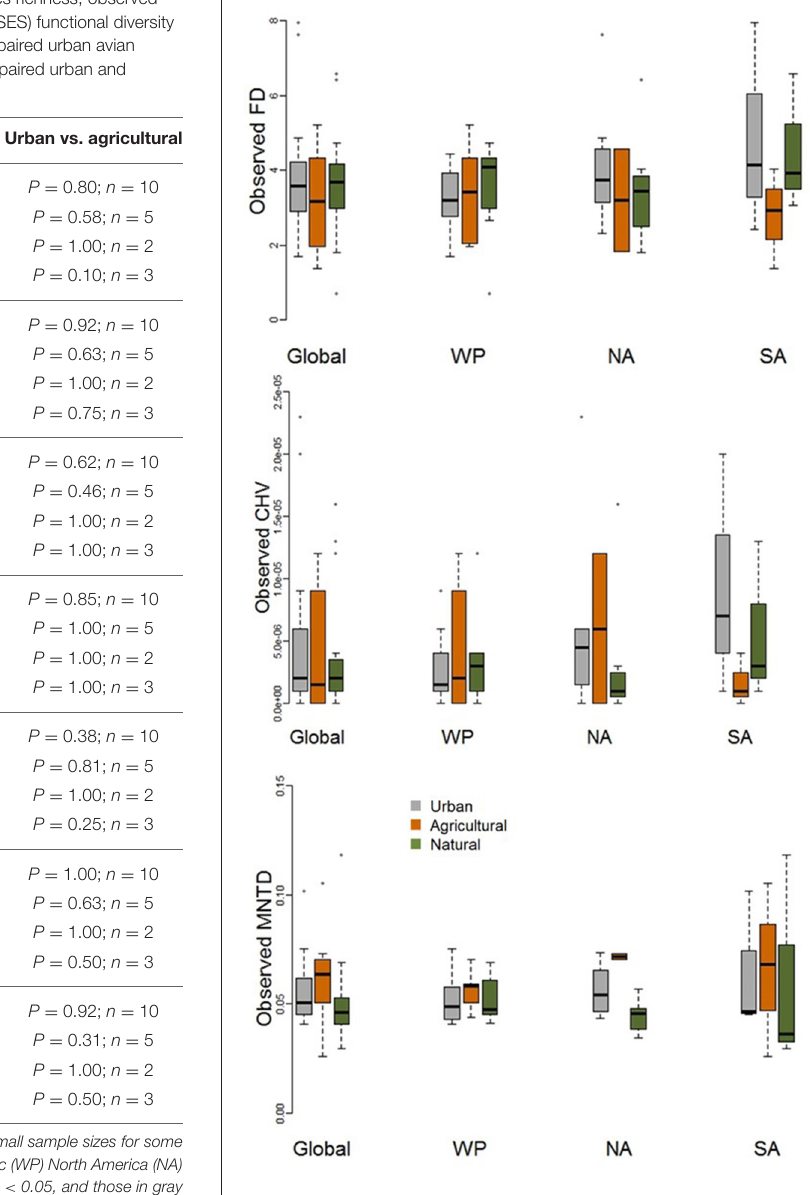
FIGURE 3 | Boxplot comparing observed functional diversity metrics (FD, MNTD, and CHV) for urban avian assemblages and their paired natural and agricultural assemblages at the global scale and for the Western Palearctic (WP), North America (NA), and South America (SA). See Table 2 for statistical